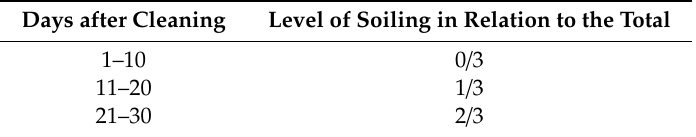
Table 3. Modulation of the plant’s contamination rate following